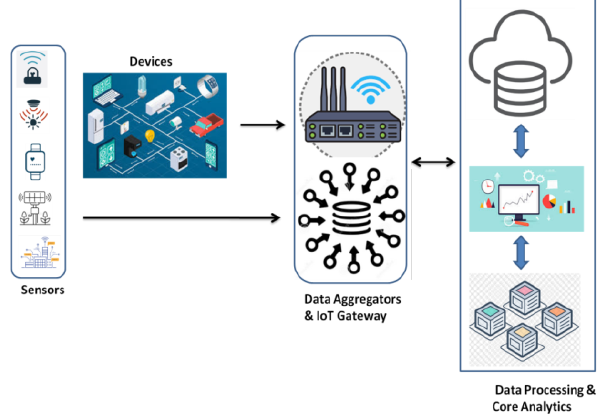
Figure 1. Cloud based IoT architecture for Patient Remote